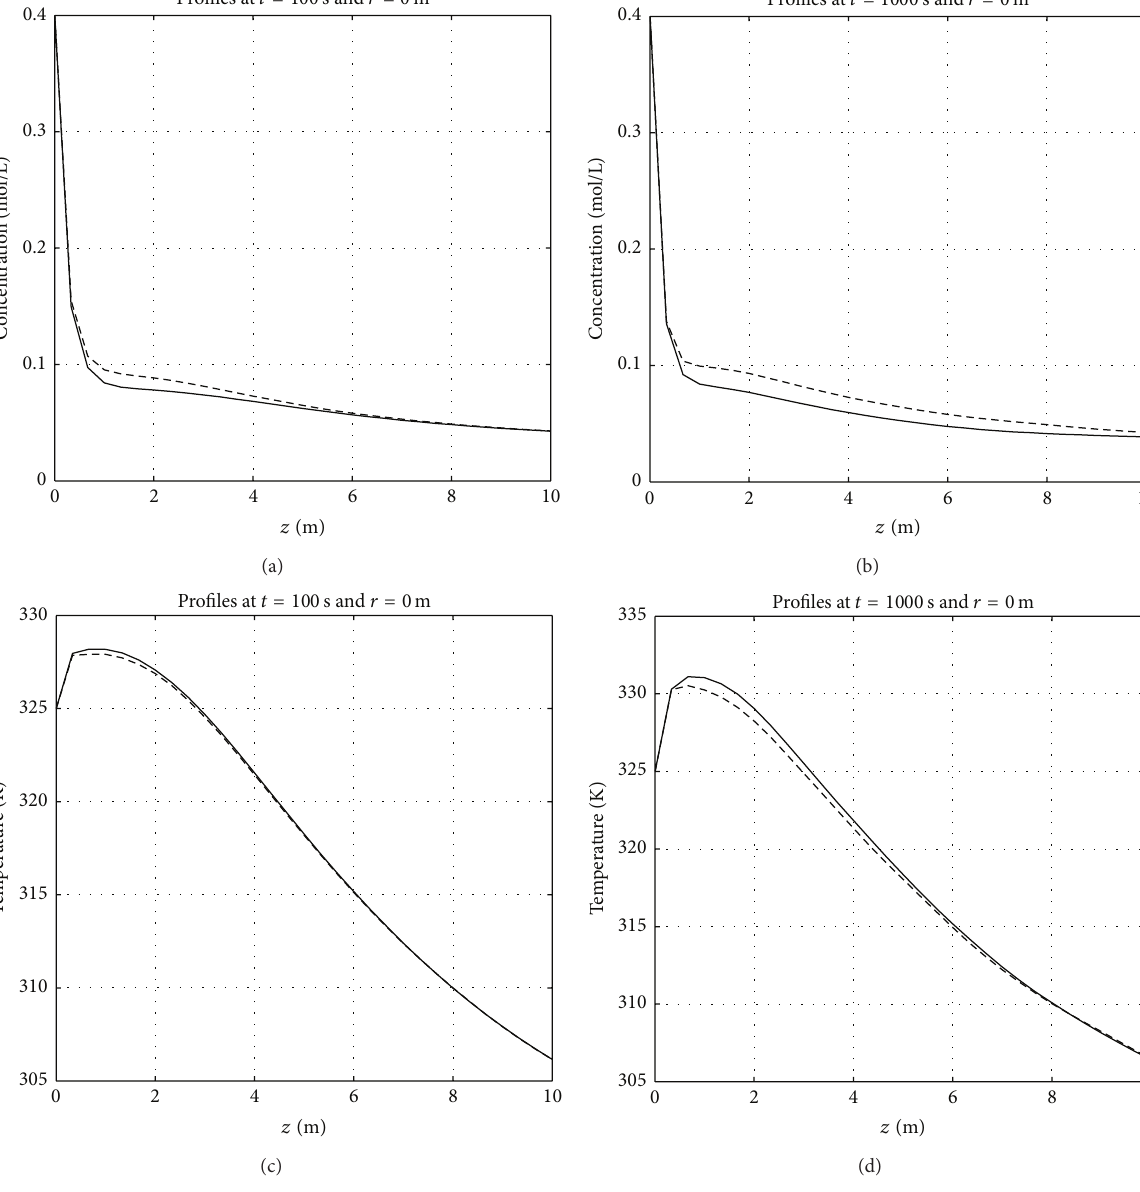
Figure 7: Temperature and concentration profiles and 𝑡 = 100 s at 𝑡 = 1000 s at 𝑟 = 0 m. Solid line—full-order model. Dashed line—reduced- order